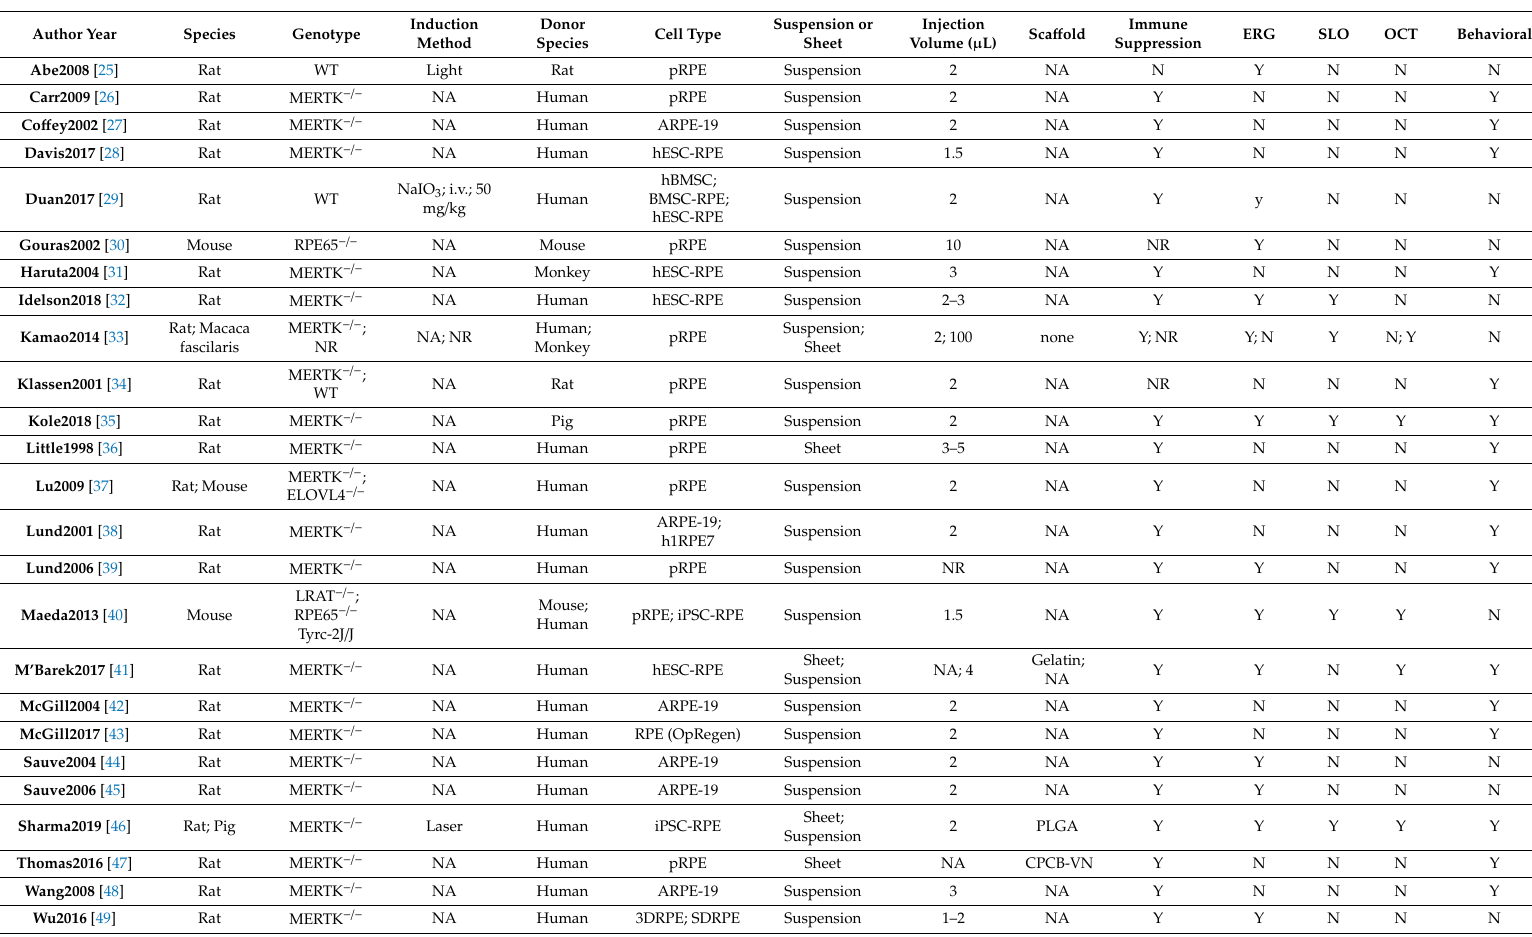
Table 1. An overview of the study characteristics of the 25 studies which were eligible for in depth analysis. WT = wildtype; NA = not applicable; NR = not reported; NaIO 3 = sodium iodate; i.v. = intravenous; pRPE = primary RPE; hESC = human embryonic stem cell; BMSC = bone marrow-derived mesenchymal stem cell; 3D = three dimensions; SD = single dimension; CPCB-VN = parylene C membrane with vitronectin; PLGA = poly lactic-co-glycolic acid; N = no; Y =